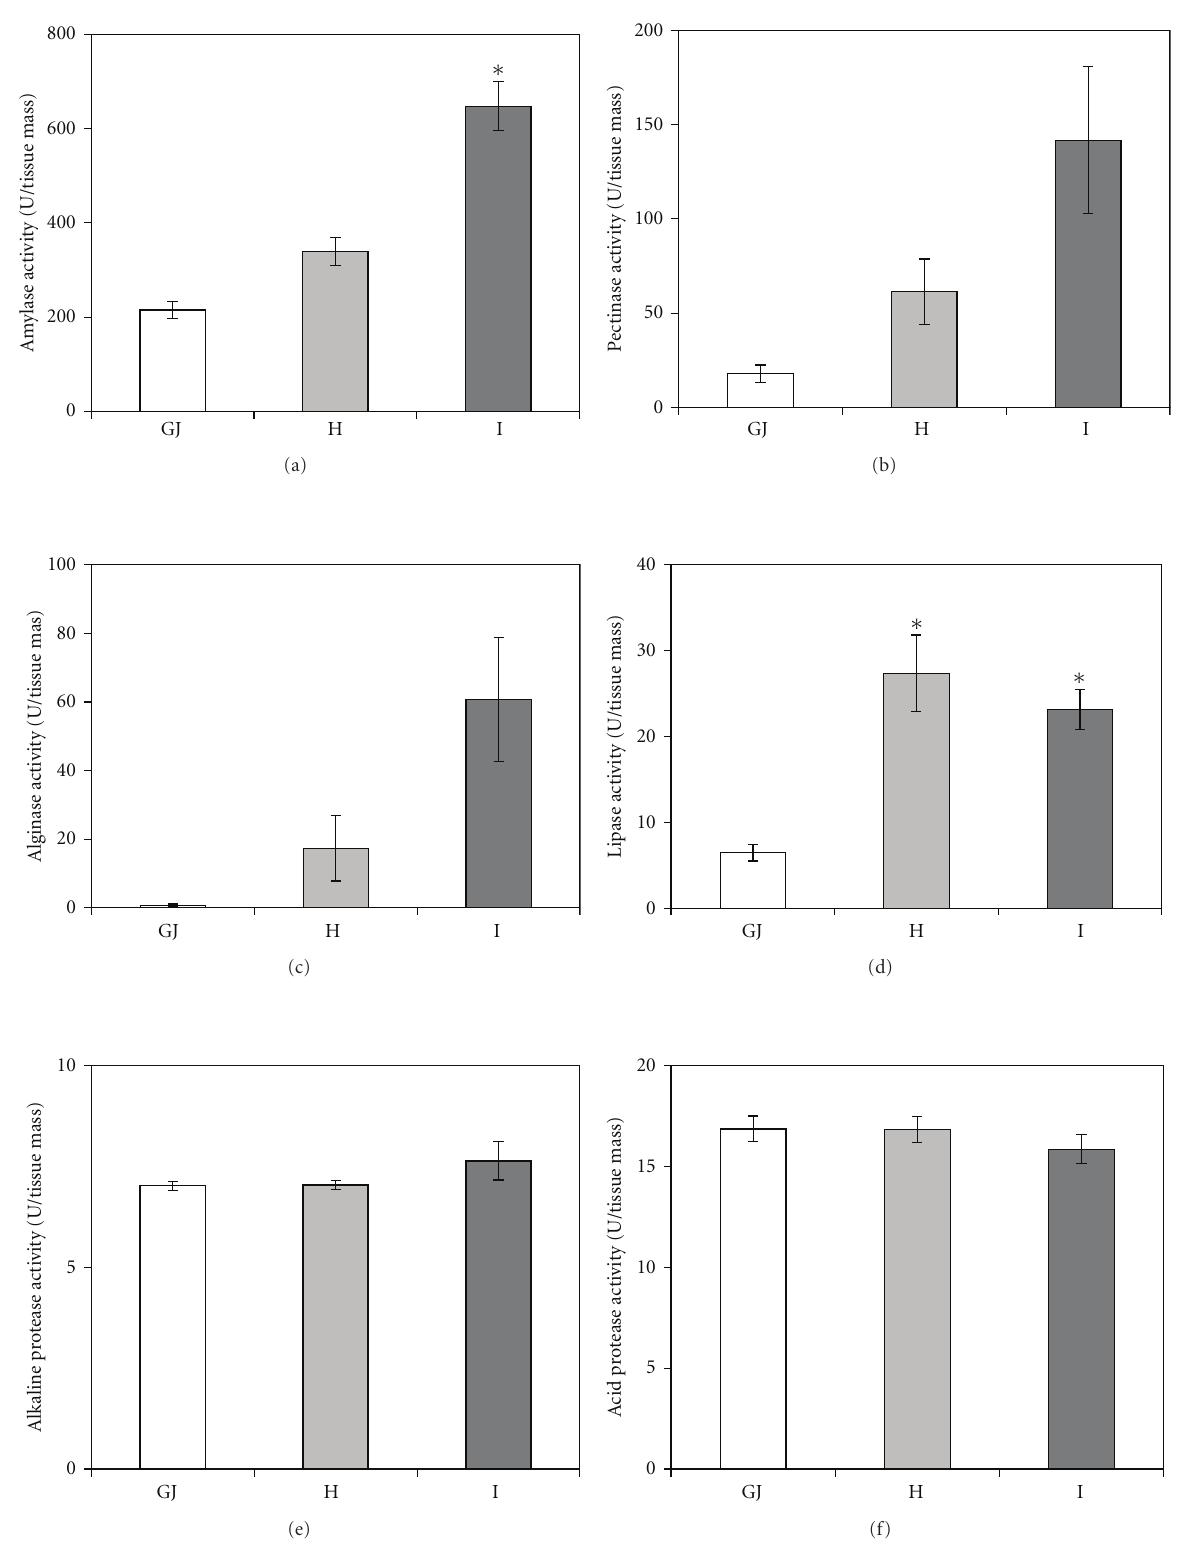
Figure 4: Enzymatic activities of amylase, pectinase, alginase, lipase, alkaline protease, and acid protease (U/tissue mass) in the gastric juice (GJ), hepatopancreas (H), and intestine (I) of Cherax albidus . Data represent means ± SEM. For each group, n = 10. Asterisks represent statistically significant di ff erences ( P < . 05) along the digestive tract. ( F (2,27) = 4.13 and F (2,27) = 3.85 for amylase and lipase,